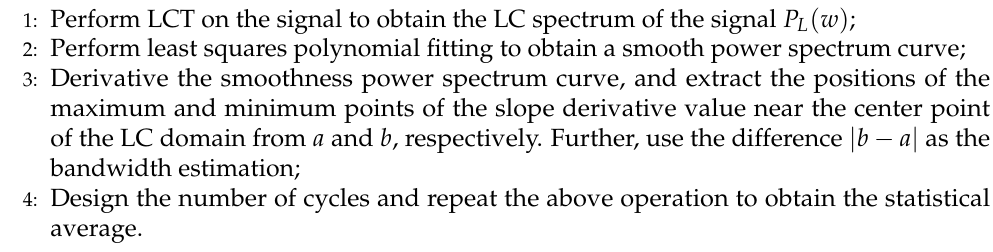
Algorithm 1 Rectangular window function bandwidth